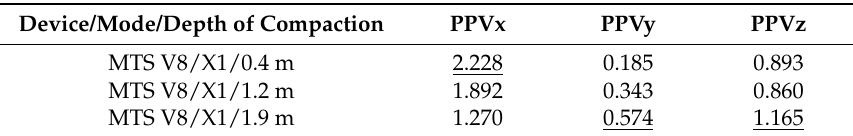
Table 8. Peak component particle velocities at the foundation wall of the building (signal integration using Sigview software)—stage III,